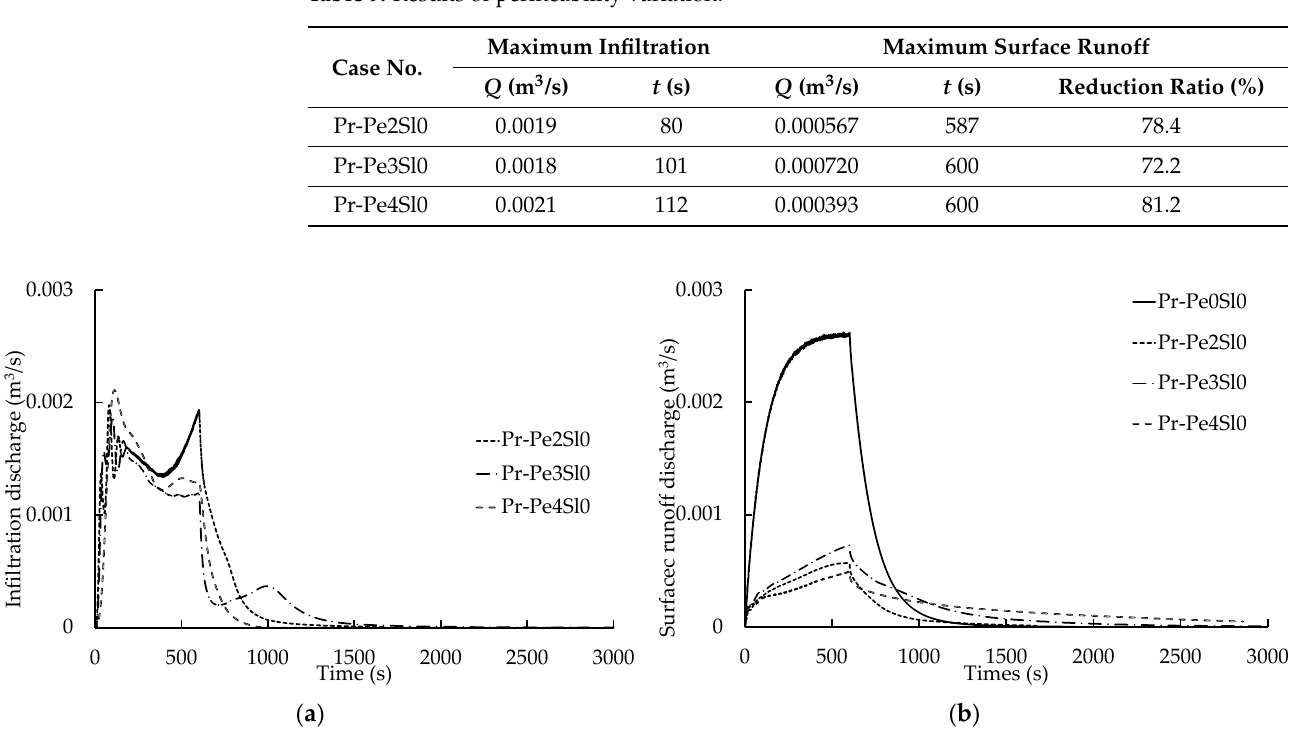
Figure 19. Results with various permeability: ( a ) infiltration; ( b ) surface runoff. Based on the maximum surface runoff and rainfall duration, the runoff of each model was shown in dimensionless form (Figure 20). As a result of the dimensionless comparison, it was possible to prevent the performance degradation of drainage facilities due to rapid surface runoff by applying the IRD system. In addition, it was found that the penetration pattern varies greatly depending on the design factor. The infiltration rate and surface runoff rate of each drainage system for total rainfall were calculated as shown in Table 10. Up to 71% of the precipitation applied to the design catchment area can be drained through infiltration with the IRD system.